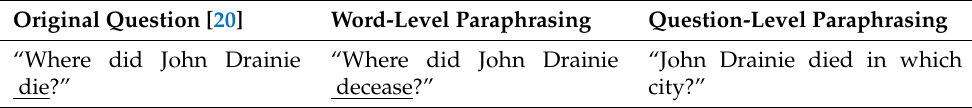
Table 9. Example of question paraphrasing. In the left column, the original question is an example of SimpleQuestions from Bordes et al. [20]. In the mid-column, the paraphrase is constructed by word level by changing the verb die into its synonyms (e.g., decease ). In the last column, the paraphrase is built by